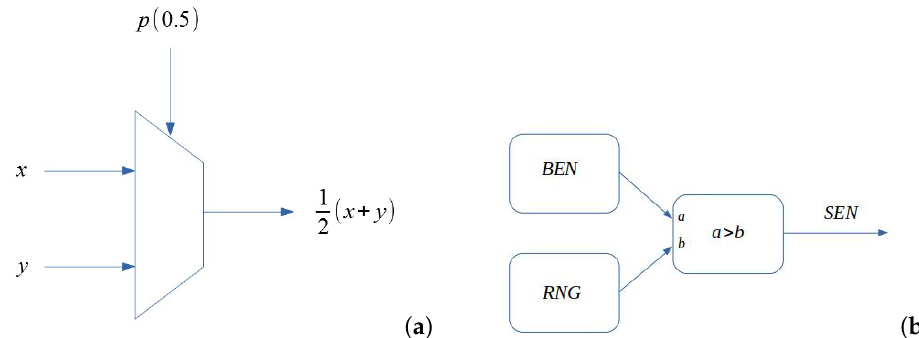
Figure 2. Basic implementation schemes ( a ) of a SC adder using a multiplexer and ( b ) a Bi- nary Encoded Number (BEN) to a Stochastic Encoded Number (SEN), using a Random Number Generator